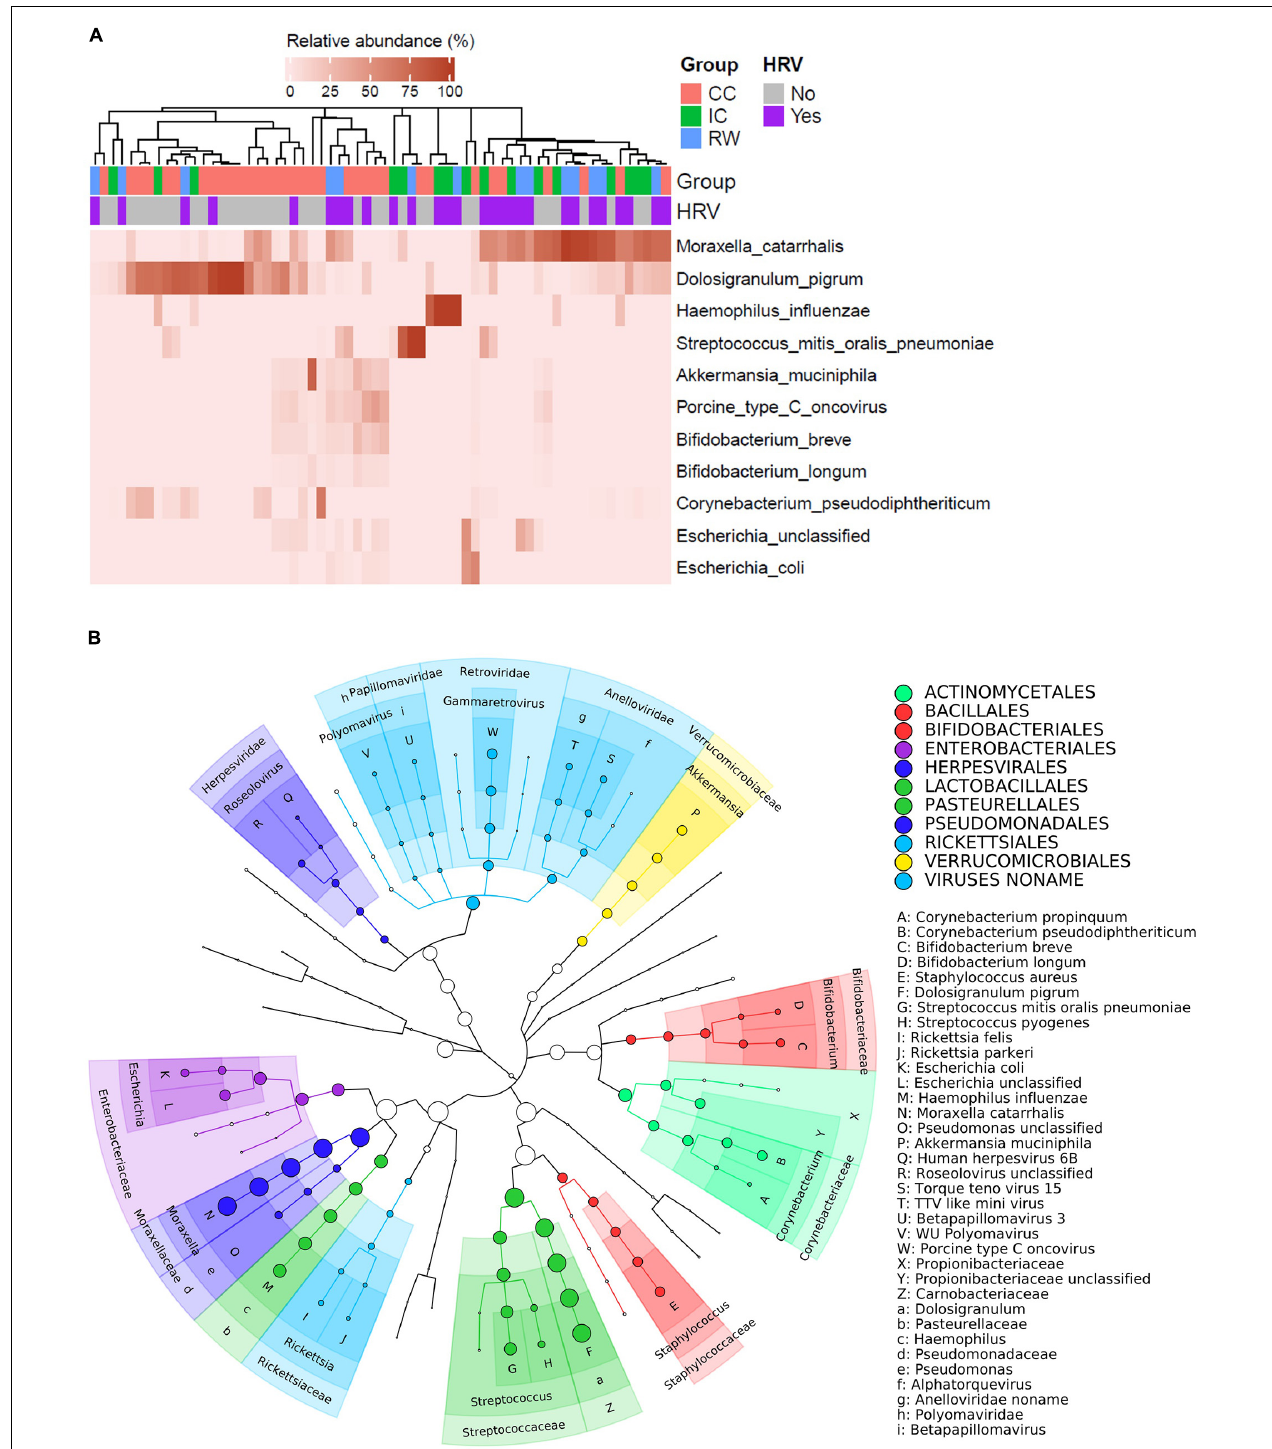
FIGURE 2 | Taxonomic profiles of NPM in all 70 subjects. (A) Heatmap showing relative abundances of the top 11 most abundant species in individual samples. Samples were hierarchically clustered based on Bray–Curtis dissimilarity of species abundances, and color coded according to group or HRV status as indicated. (B) Taxonomic cladogram illustrating the phylogenetic diversity of microbial species (bacteria and viruses) found in all samples. Size of the node was proportional to the relative abundance for the corresponding taxon. Family and genus-level annotations were labeled on the tree, with some of which annotated using X–Z and a–i keys to avoid image overlapping. Species with minimal relative abundance threshold of 1% were annotated using A–W as keys. Order-level microbes are indicated by different colors shown in the legend.